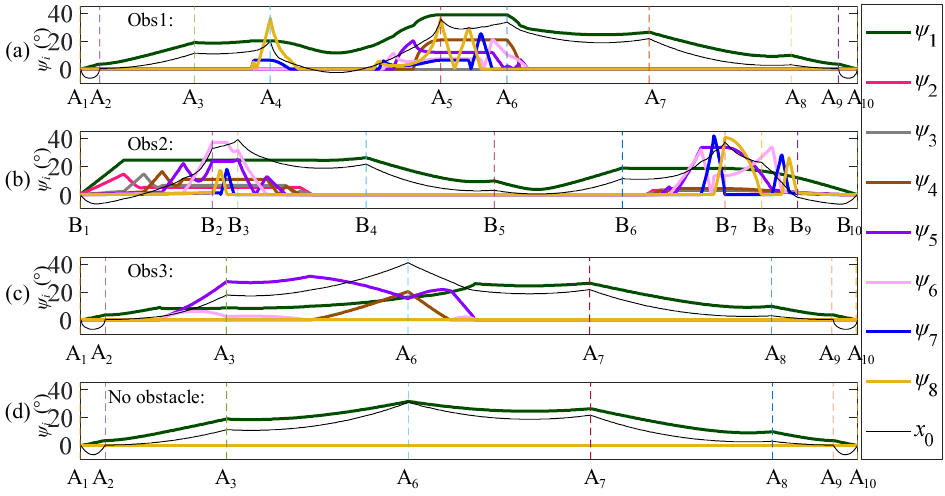
Figure 14. Variation curves of ψ i and x 0 in four environments. ( a ) Parameter change curve in obs1; ( b ) Parameter change curve in obs2; ( c ) Parameter change curve in obs3; ( d ) Parameter change curve without obstacles.